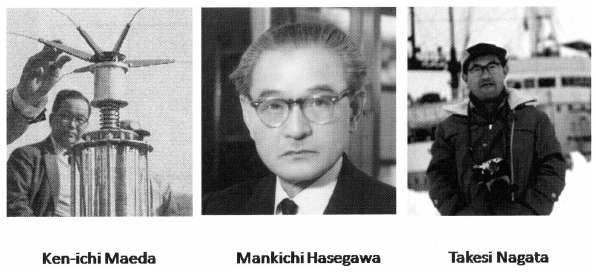
Figure 17. Japanese leaders at the time of IGY: K. Maeda (1909– 1995), M. Hasegawa (1894–1970) and T. Nagata (1913–1991). All the pictures were dated between 1955 and